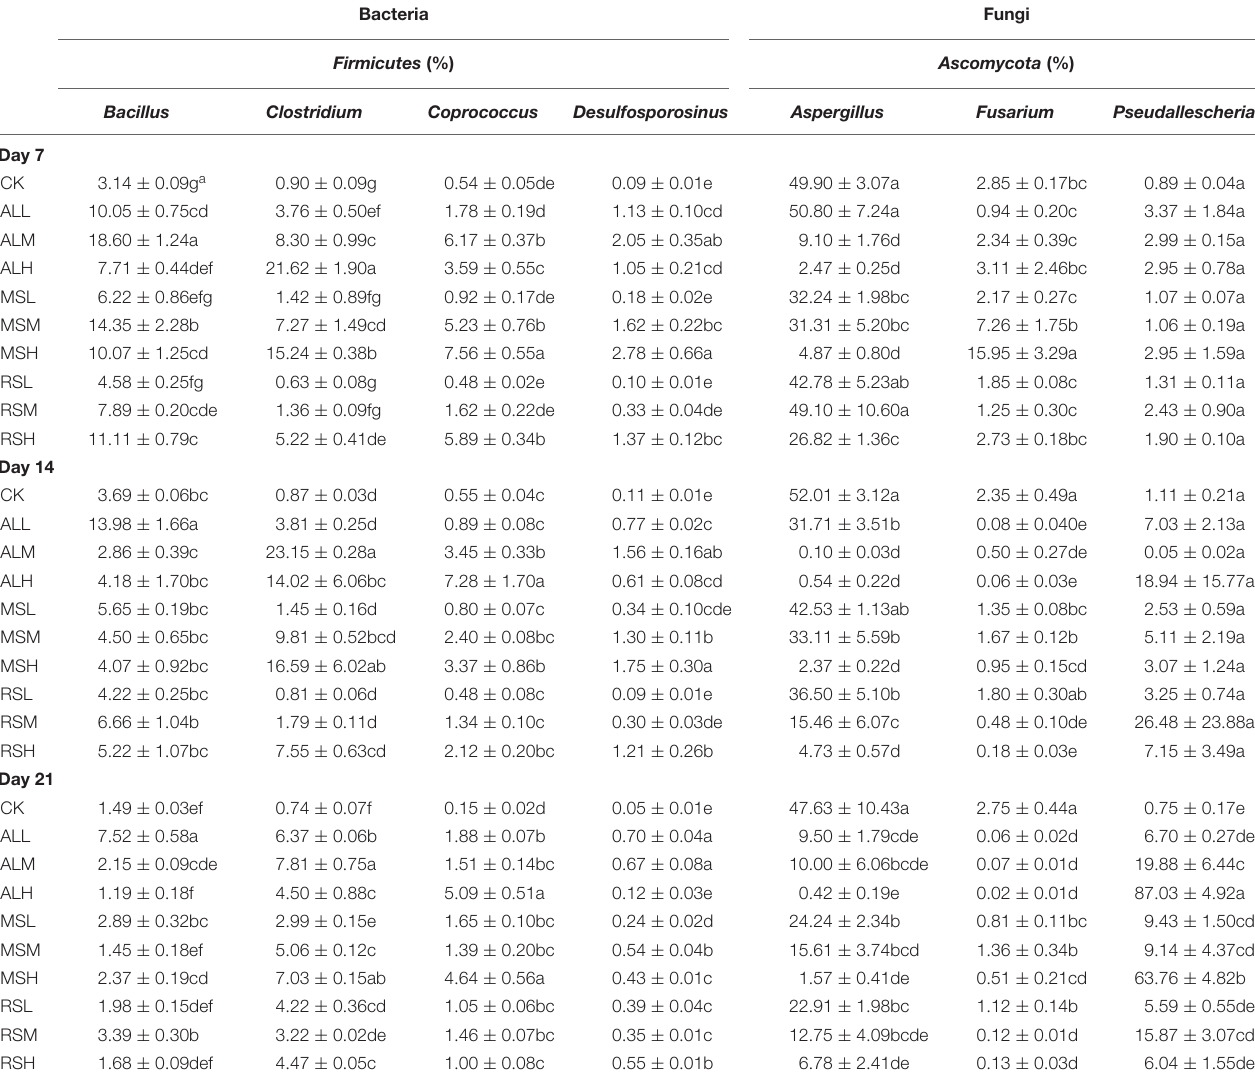
TABLE 2 | Relative abundances of dominant functional genera and pathogenic genera of bacteria and fungi during RSD treatment. Bacteria